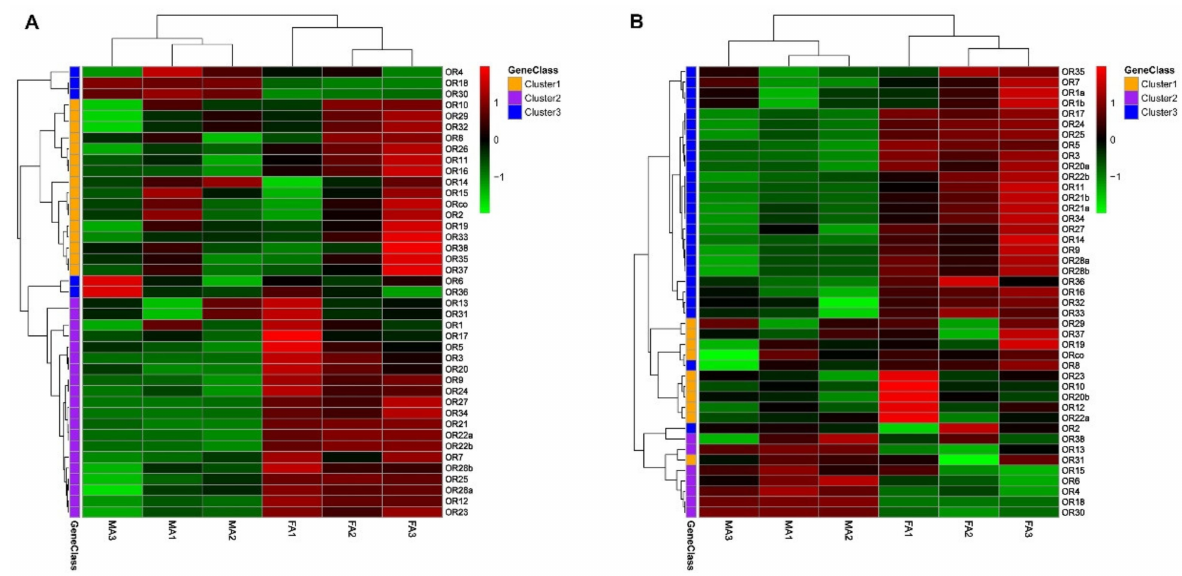
Figure 1. Expression profiles of OR genes in antennae. ( A ) S. noctilio , ( B ) S. nitobei . FA: female antennae, MA: male antennae, the FPKM-values were used for calculating transcript